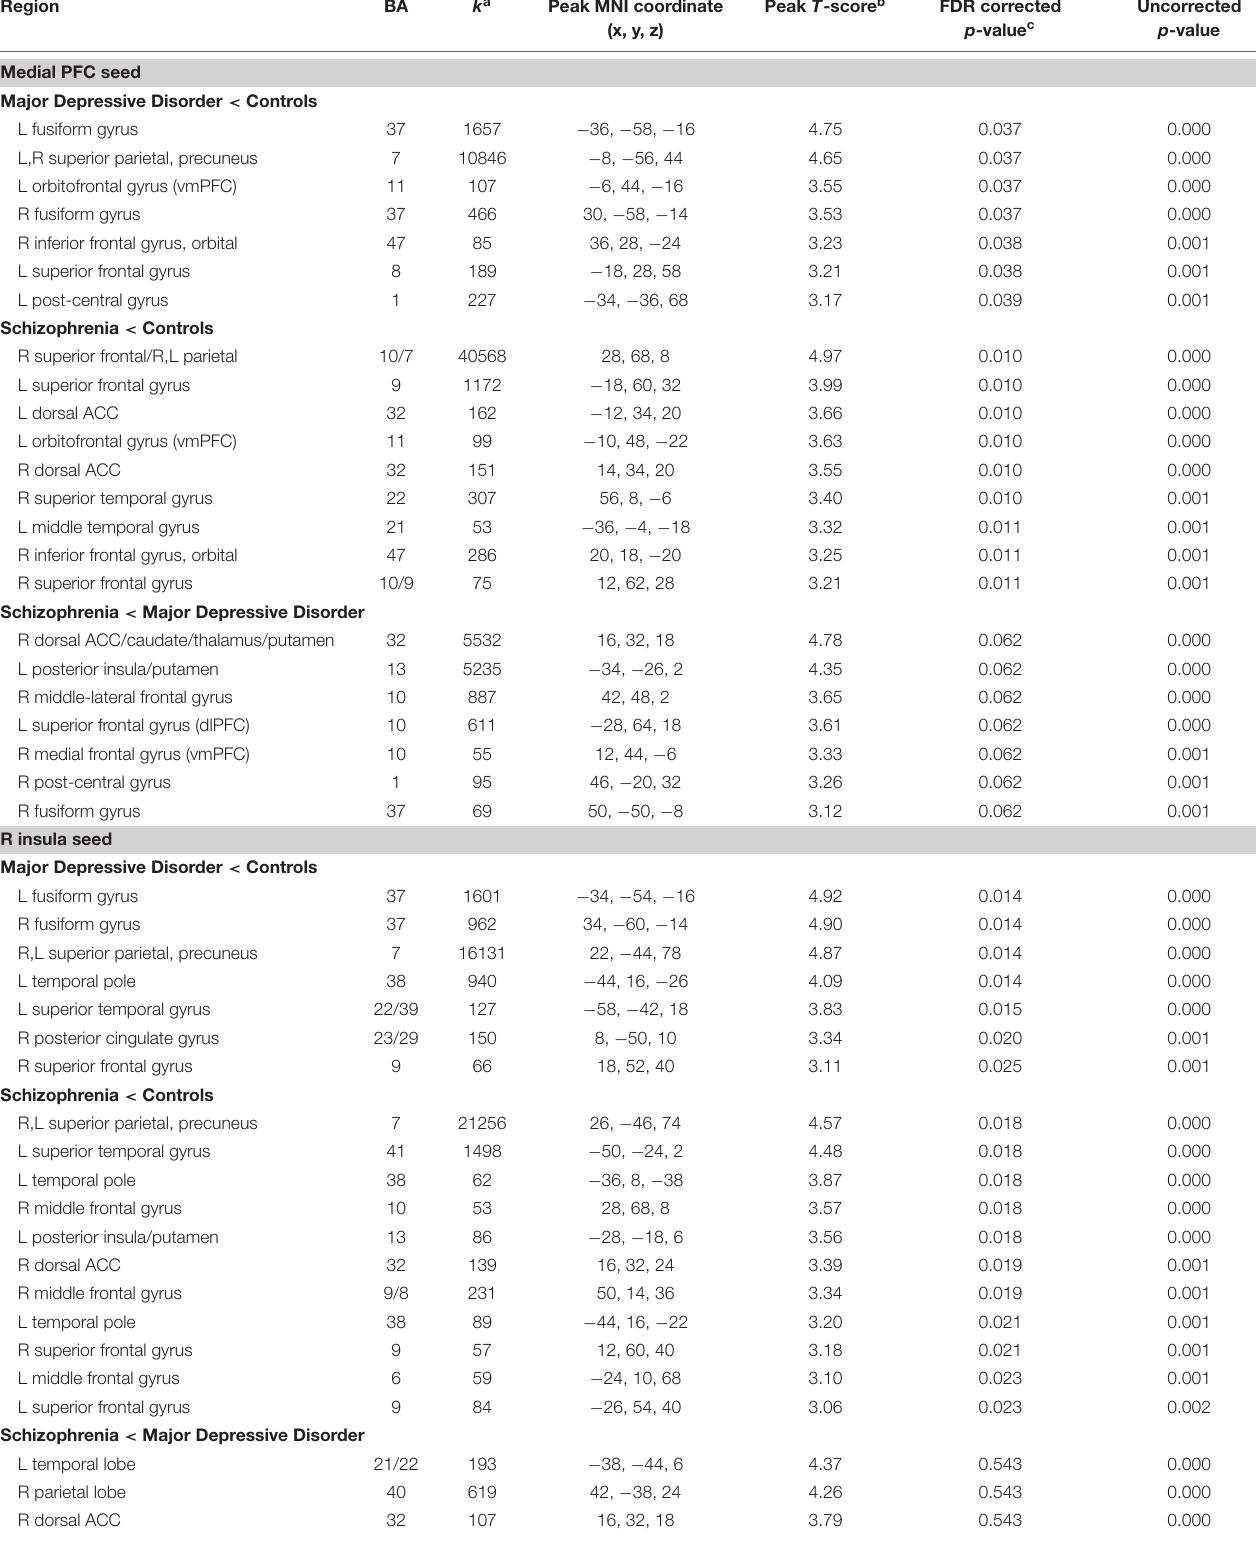
TABLE 3 | Clusters of between-group seed connectivity differences. Region BA k a Peak MNI coordinate